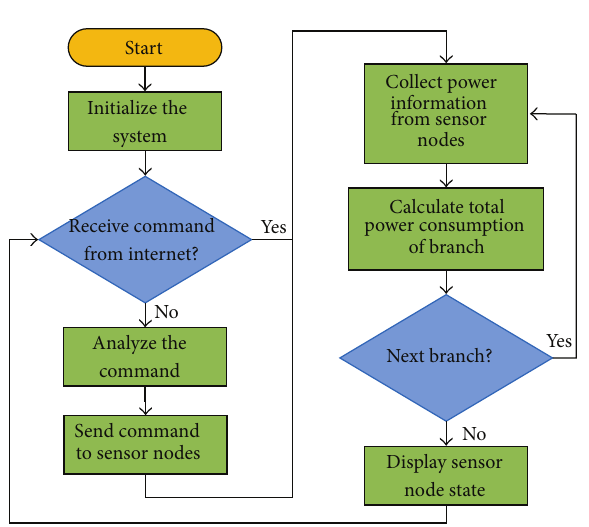
Figure 3: Software flow chart for the base station.